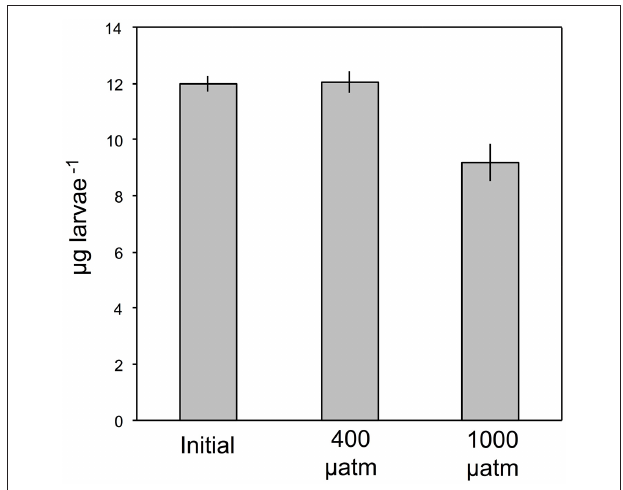
FIGURE 3 | Lipid content of P. damicornis larvae ( µ g larvae − 1 ) following release from the maternal colony and after 24-h exposures to ambient and high pCO 2 , pooled between 0.3-m MD and 3.3-m MD (mean ± SE, n = 6).